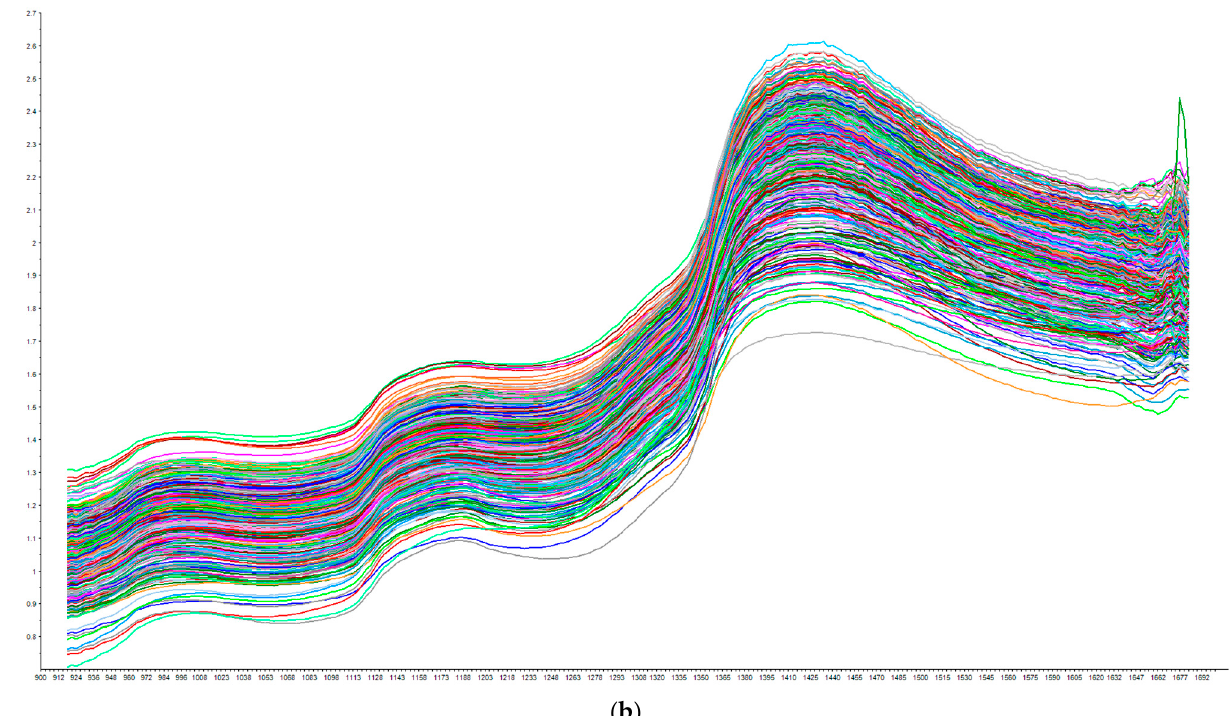
Figure 1. ( a ) Raw near-infrared spectra collected on all pork belly fat samples (N = 158) using the Tellspec NIR device. X axis = Absorbance; Y axis = Wavelength (nm). ( b ) Raw near-infrared spectra collected on all loin chop lean samples (N = 419) using the Tellspec NIR device. X axis = Absorbance; Y axis = Wavelength (nm).